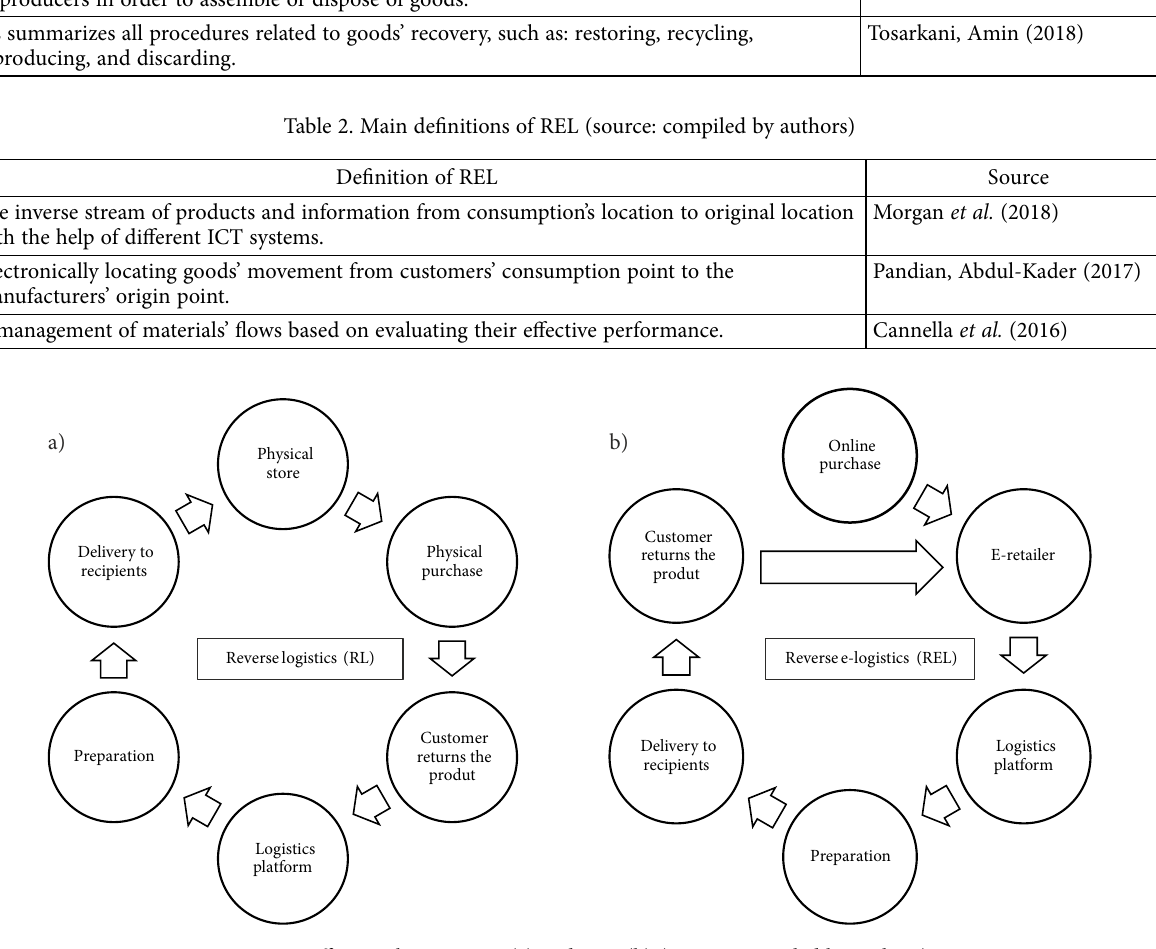
Figure 1. Difference between RL (a) and REL (b) (source: compiled by